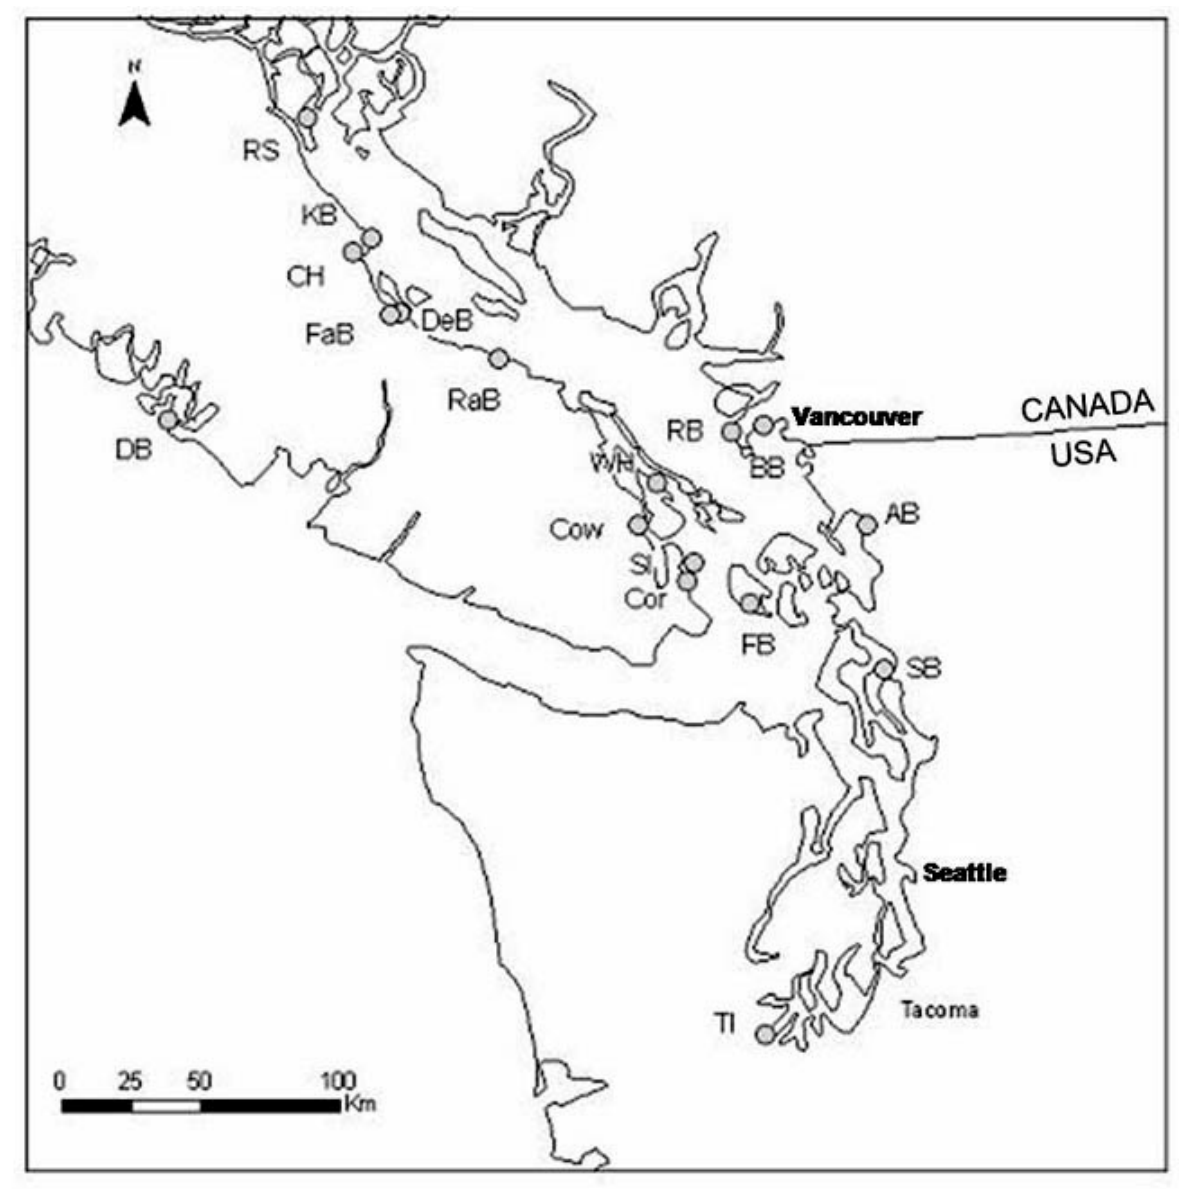
Fig. 1. The Georgia Basin/Puget Sound region of British Columbia, Canada and Washington,